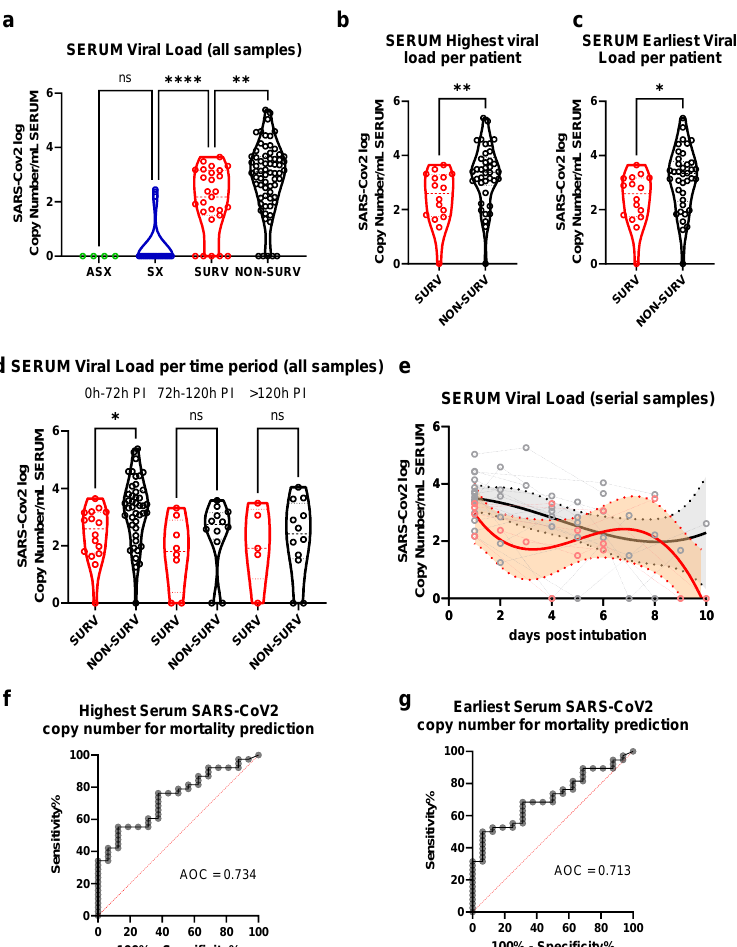
Figure 1. SARS-CoV-2 viral load in serum samples from SARS-CoV-2 patients. Serum was obtained from patients admitted to the ICU with COVID-19 associated acute respiratory failure diagnosis divided by their mortality outcome (SURV survival, NON-SURV non-survival), a hospitalized non- ICU group on supplemental oxygen “SX”, and a non-hospitalized group “NH”. In some ICU patients, serum sampling was performed at multiple time points. ( a ) Violin plots of median and quartile SARS-CoV-2 copy numbers of individual samples pooled from all time points post-intubation are shown. Circles show data for each patient. Asterisks indicate significant differences between groups according to one-way ANOVA followed by Bonferroni post-analysis. ( b ) Student t-test anal- ysis of ICU samples with the highest viral load per patient and ( c ) earliest sample available per patient. ( d ) A pooled analysis divided by sampling period after intubation (PI) was performed by ANOVA and Bonferroni. ( e ) A non-linear regression analysis of serial samples (patients that had two or more samples during the study) is shown. Non-linear regression graph shows individual patient trajectories with dotted lines and 90% CI as filled space. ROC curve-analysis for ICU mor- tality prediction according to ( f ) highest or ( g ) earliest SARS-CoV-2 copy number is shown. AUC = area under the ROC curve; ns = non-significant; * = p < 0.05; ** = p < 0.01; **** = p < 0.0001.